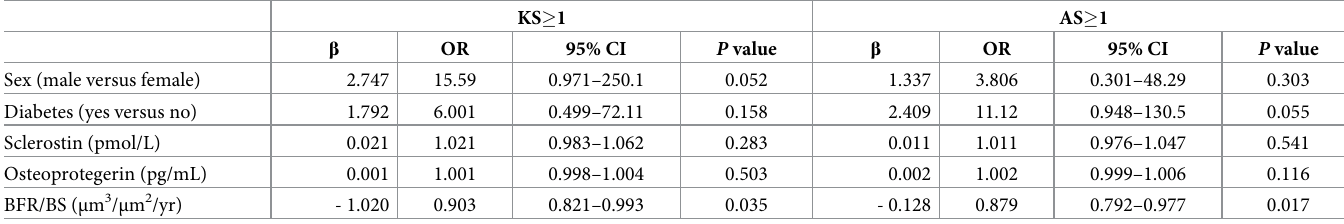
Table 4. Multivariable logistical regression analysis for prediction of vascular